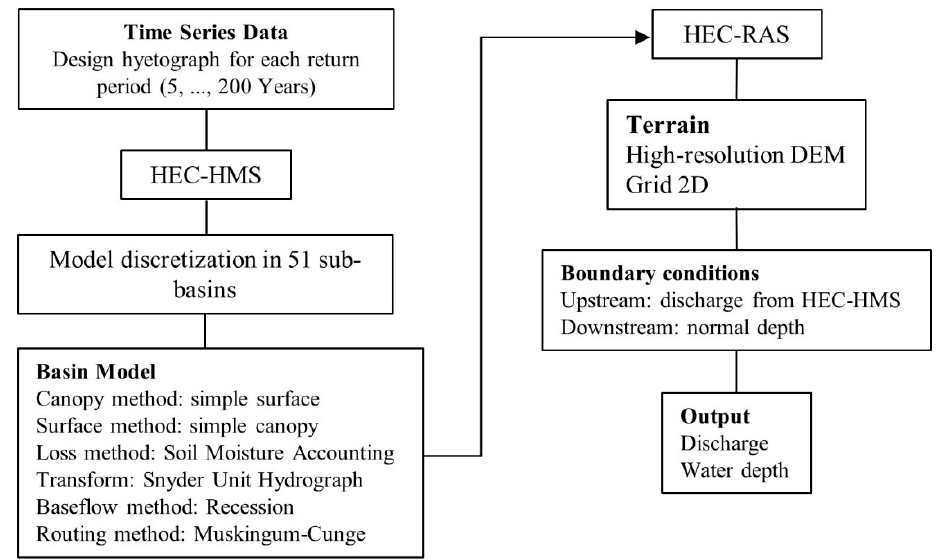
Figure 3. Scheme of the hydrological and hydrodynamic modeling.